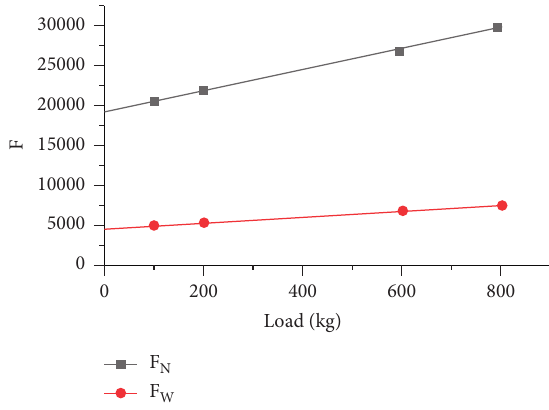
Figure 15: Change curve of F